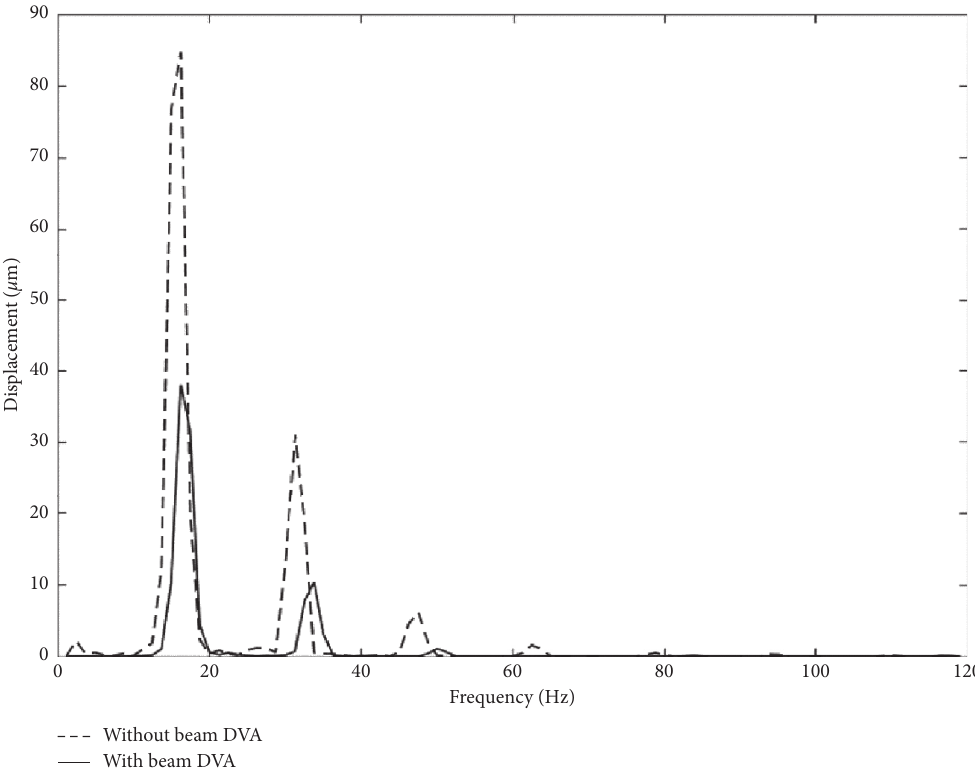
Figure 12: Experimental results of the 2-inch pipeline structure with the inverter operating at around